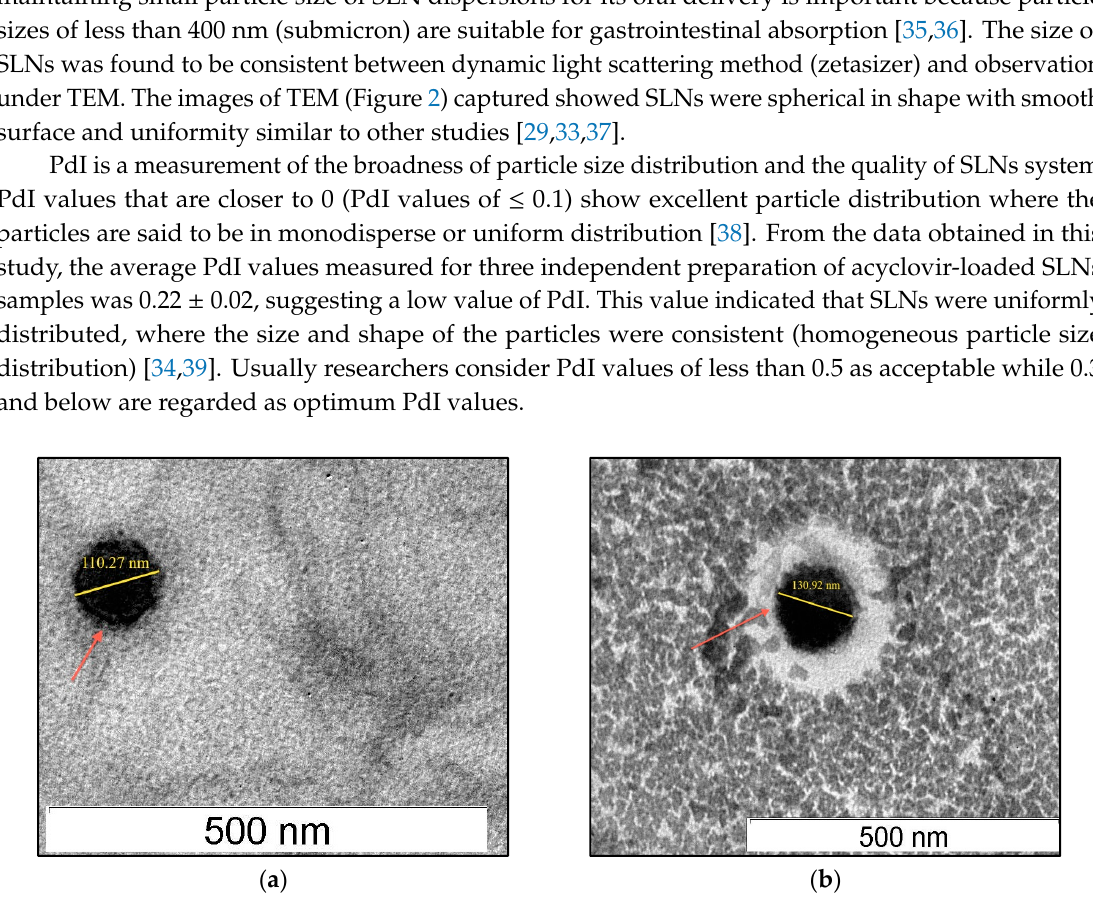
Figure 2. Transmission electron micrograph at 60,000 × magnification of: drug-free SLNs ( a ); and acyclovir-loaded SLNs ( b ).